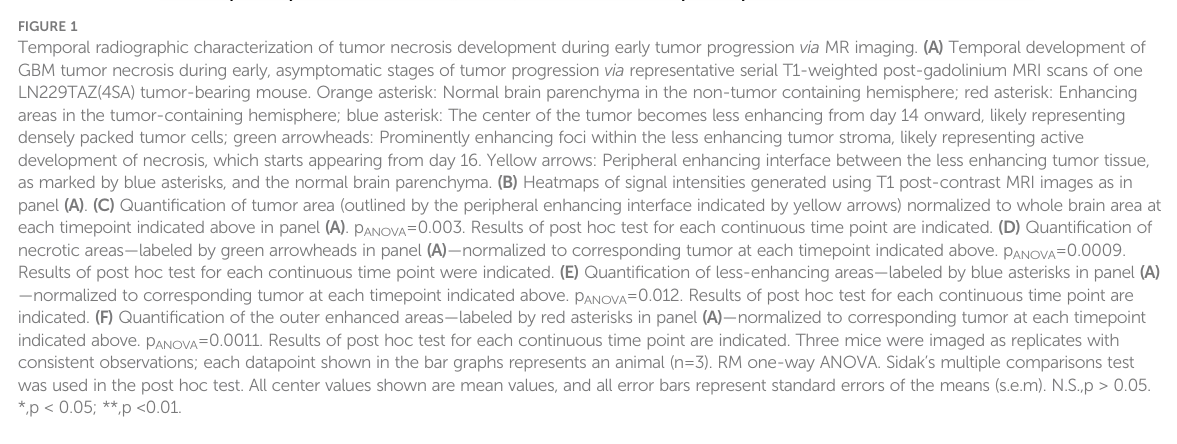
quanti fi cation. Necrosis (N) is de fi ned as acellular regions (appearing pale pink) within tumors as identi fi ed by H&E stain, and a cellular tumor (CT) region is de fi ned as a hypercellular region. Quanti fi cation was performed using